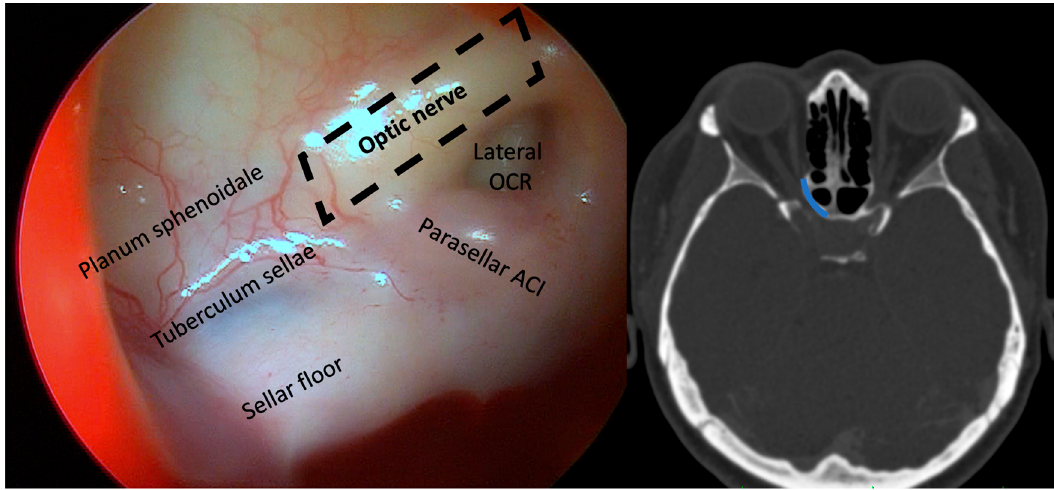
Figure 1. Left : sphenoid sinus view of the left ON and parasellar internal carotid artery. The dotted line outlines the optic canal. Right : axial CT imaging in bone window. The line highlights the extent of optic canal decompression.